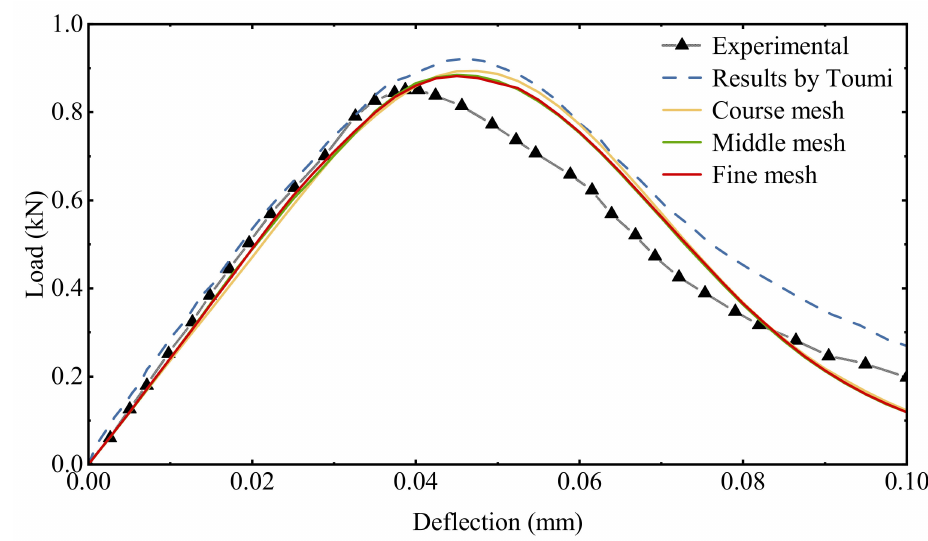
Figure 9. Comparison of the load-deflection curve between test and numerical results.